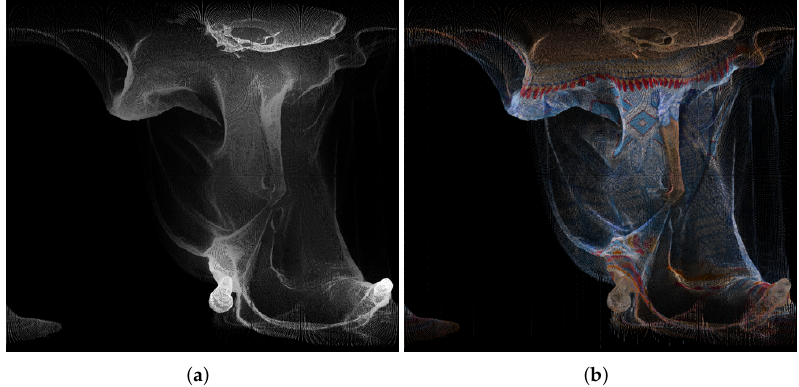
Figure 6. Panorama images created using point cloud “longdress_vox10_1060.ply” from the Mercator projection, for the geometry ( a ) and texture ( b ).